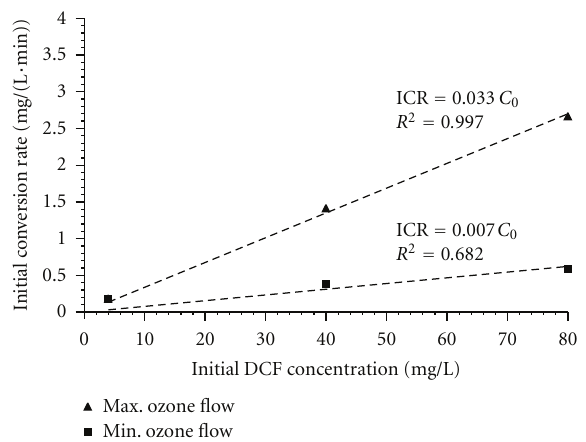
Figure 4: Comparative rates of diclofenac organic carbon decay in terms of TOC by ozonation (ozone flow = 31 g/h).